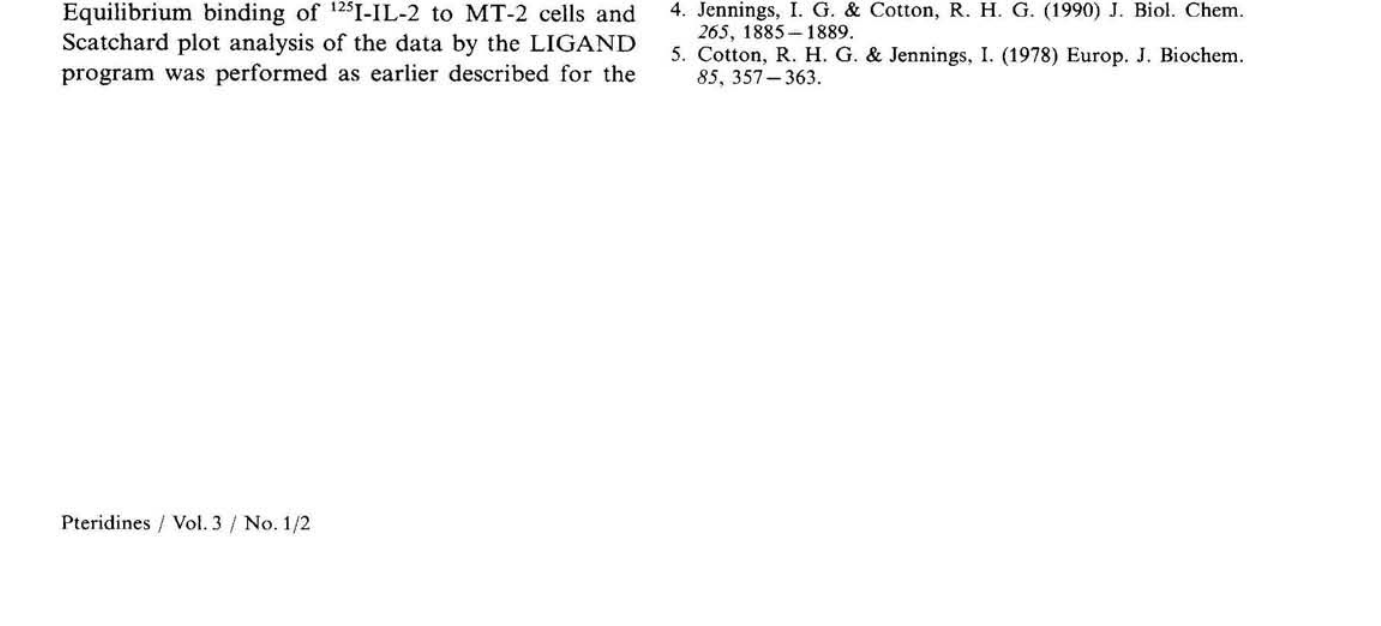
Together with the results obtained by the two anti- body sandwich assay, the data suggest that membrane class I HLA antigen is the major pterin binding poly- peptide in MT-2